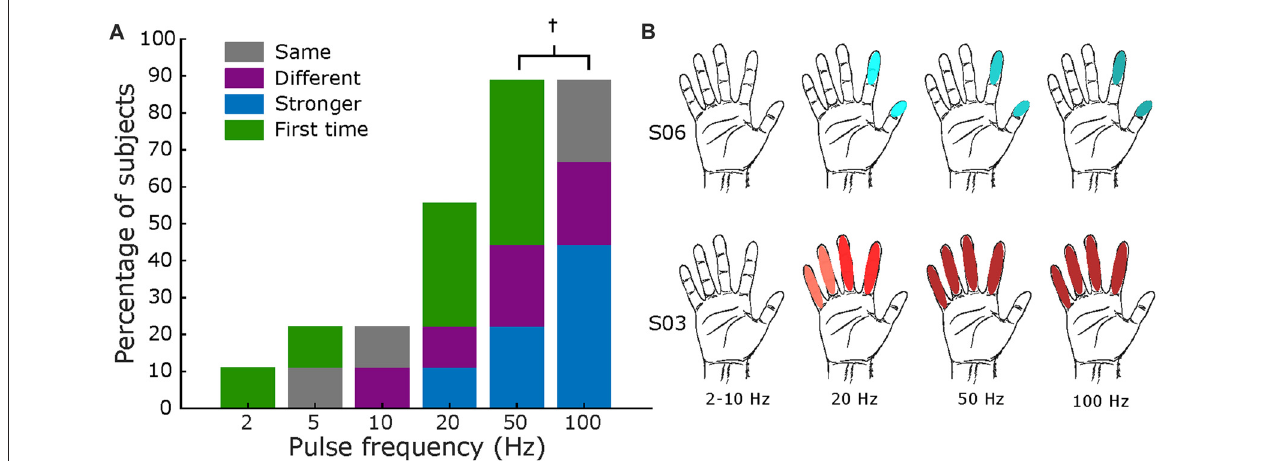
FIGURE 7 | Frequency mapping. (A) Percentage of subjects that reported sensations across all tested frequencies. Same format as Figures 5 , 6 . Total subjects: nine, fixed amplitude 2–3 mA, and fixed pulse width = 500 µ s († values only tested in eight subjects). (B) Exemplar receptive fields for S03 and S06, darker shades represent a stronger sensation. Main elicited sensations were “pressure” for S06 and “electricity” for S03.